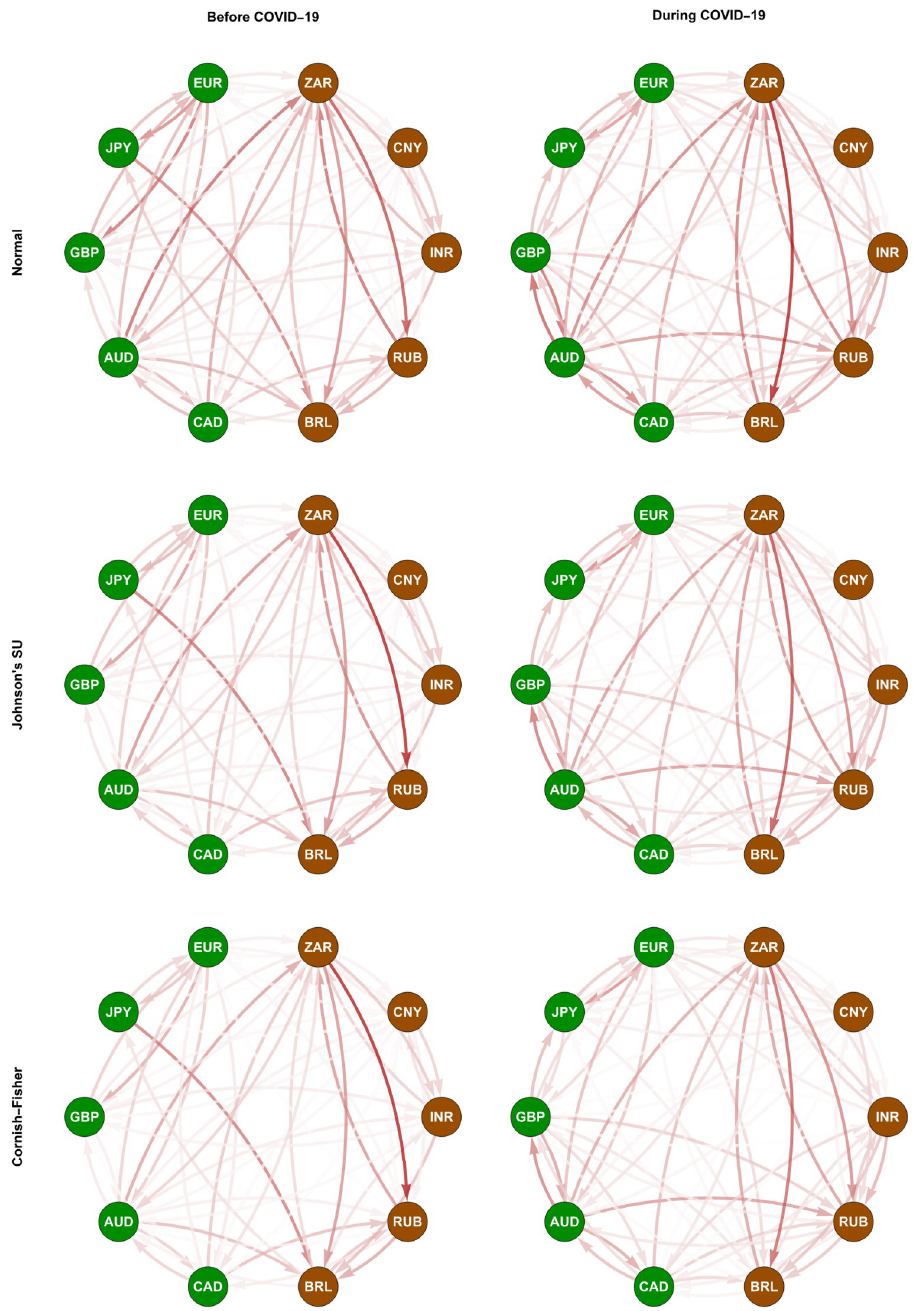
Fig 7. Conditional tail risk networks based on Δ MCoVaR forecasts. The green and brown nodes represent the advanced and emerging forex markets, respectively. The darkness of each edge indicates the magnitude of its weight, as we present in Fig